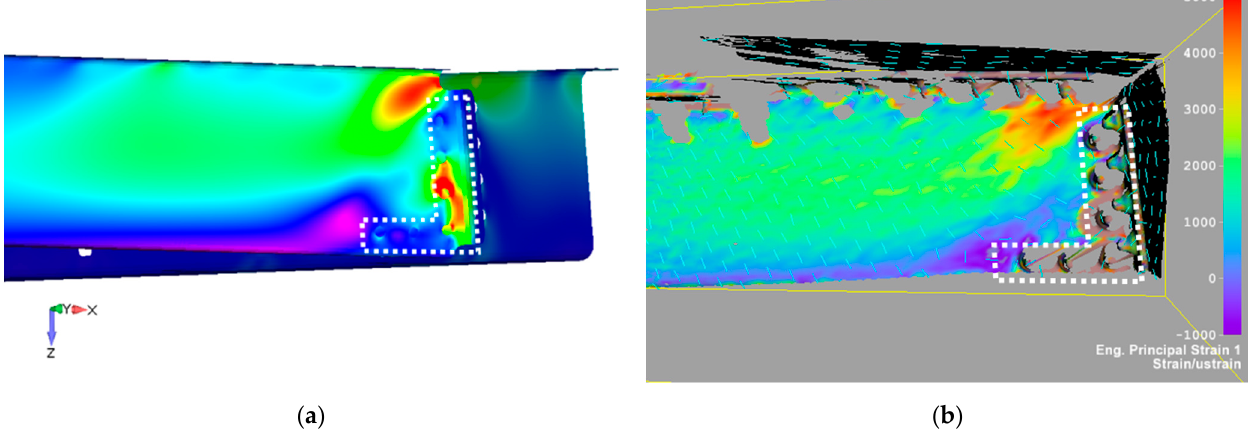
Figure 25. Comparison of principal strain contour map between the FE simulation ( a ) and DIC measurement ( b ) after a fatigue load for the LL level (115 kN) considering fatigue damage of the hinges (crack no. 1).